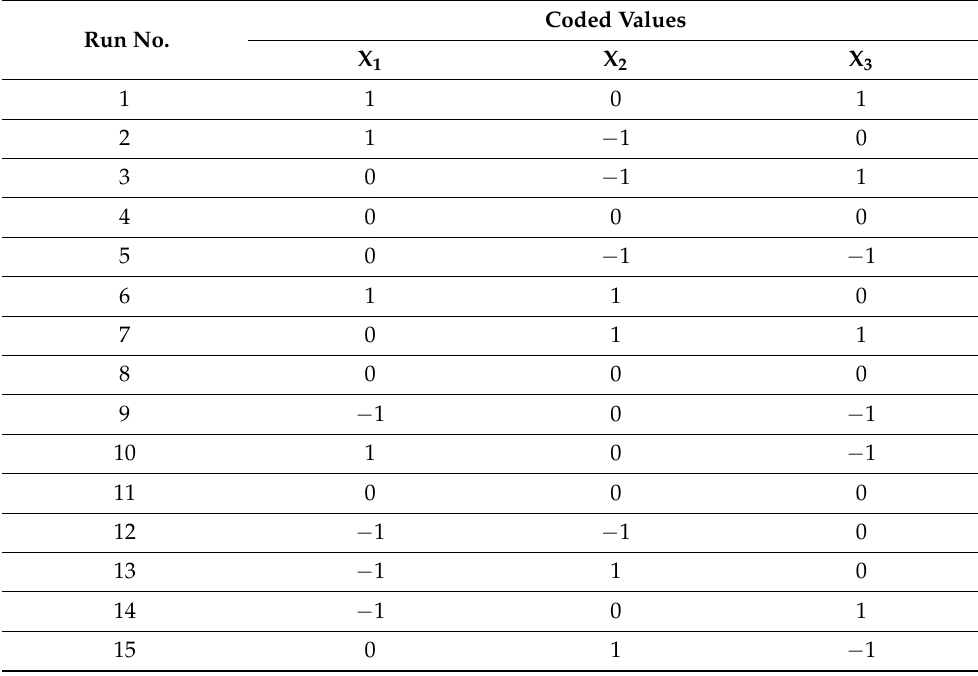
Table 2. The Box–Behnken (BBD) design of experiments. Run No.